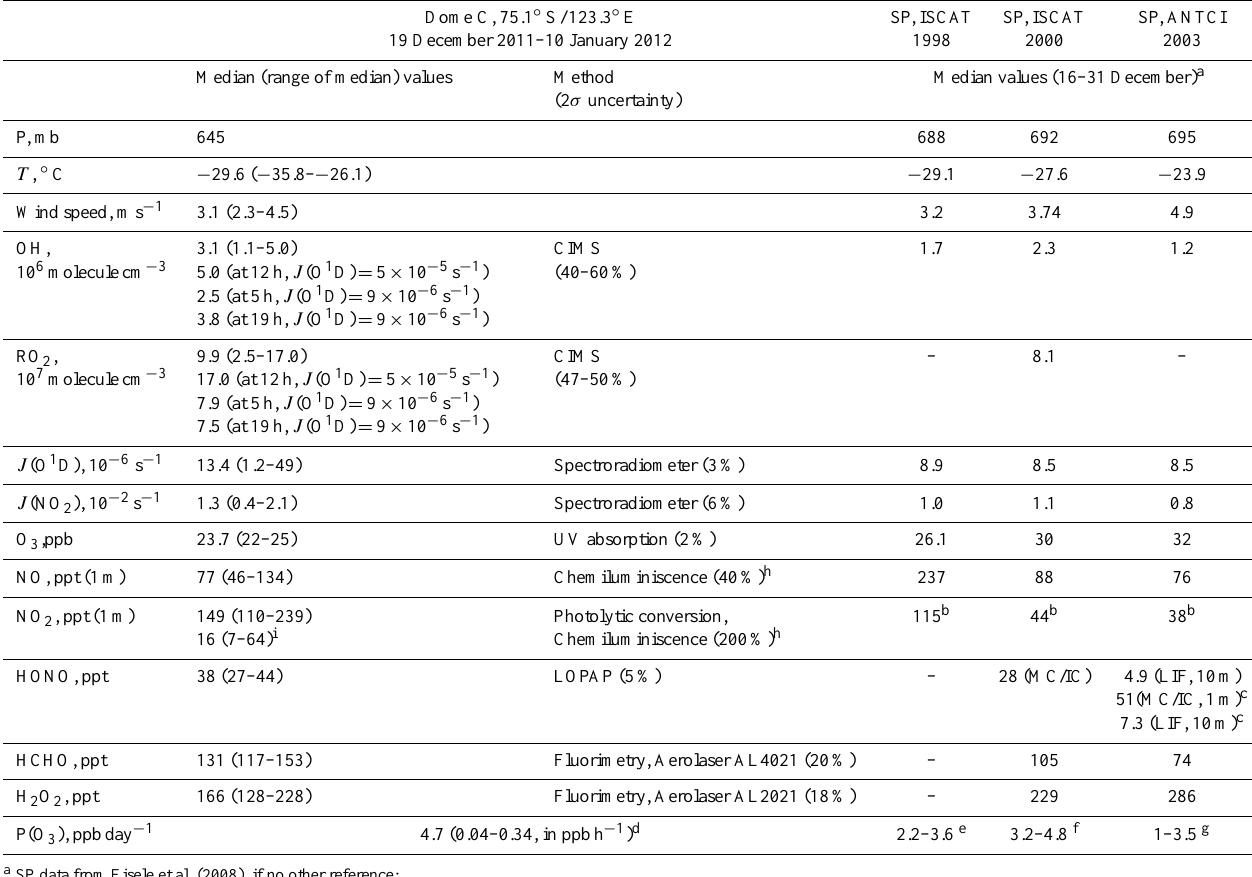
Table 1. Comparison of measurements at Dome C and at the South